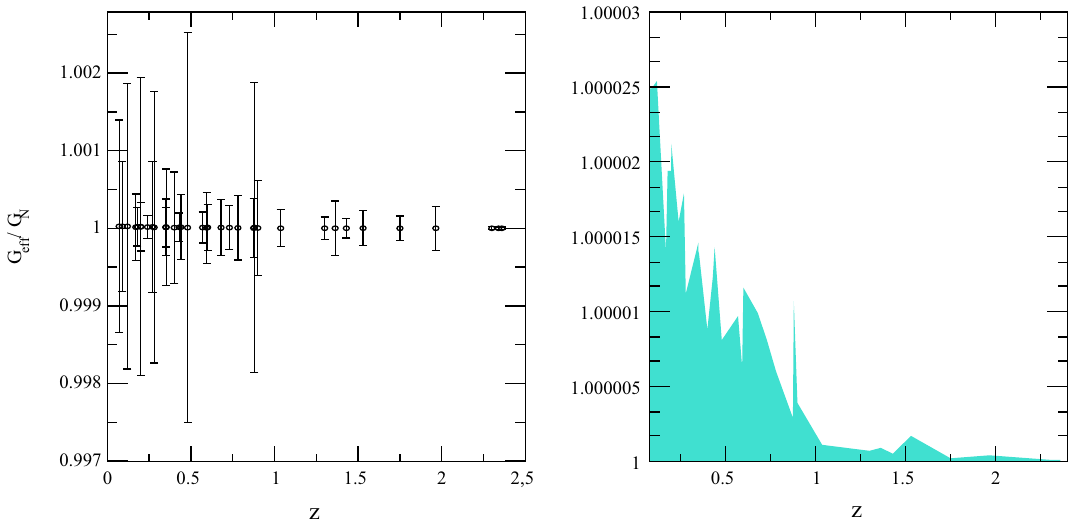
Fig. 6 Results for the f 2 CDM square-root-exponential model of (15). Left graph estimation of G eff / G N as a function of the redshift, from 37 Hubble data points. Right graph reconstruction of G eff / G N as a function of the redshift, from the observational Hubble parameter data, for b ≡ 1 / p ∈ [ 0 , 0 . 5